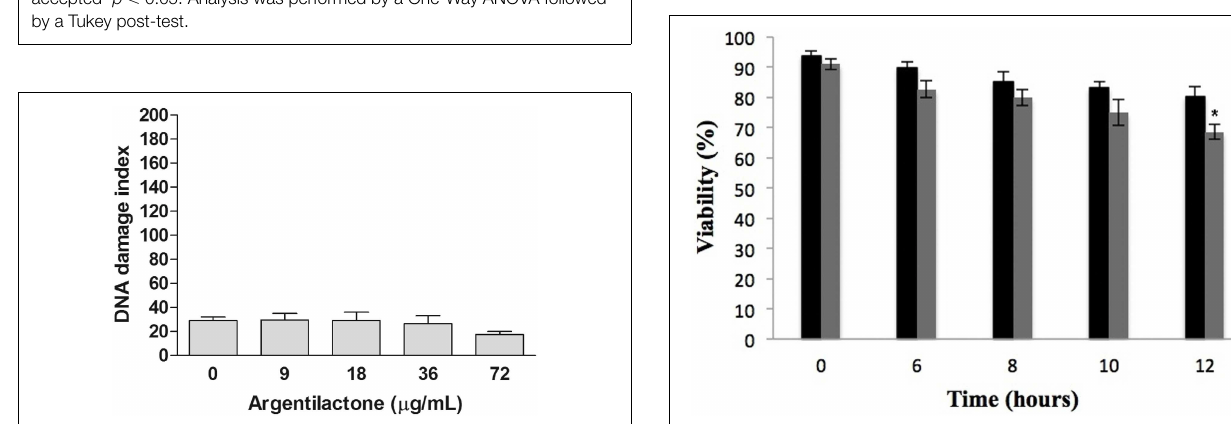
FIGURE 2 | Effect of argentilactone on the induction of MRC5 cells DNA damage. Cells were treated with 9, 18, 36, and 72 µ g argentilactone for 24h and analyzed by comet assay. Analysis was performed by a One-Way ANOVA followed by a Tukey post-test.